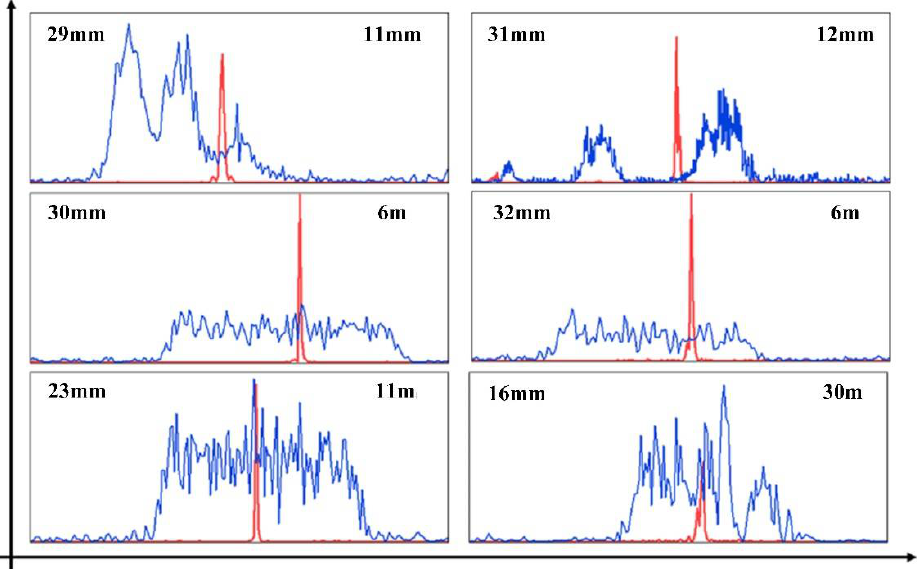
Figure 8. Frequency spectrum of the results obtained by FFT (blue line) and Lomb–Scargle algorithm (red line).